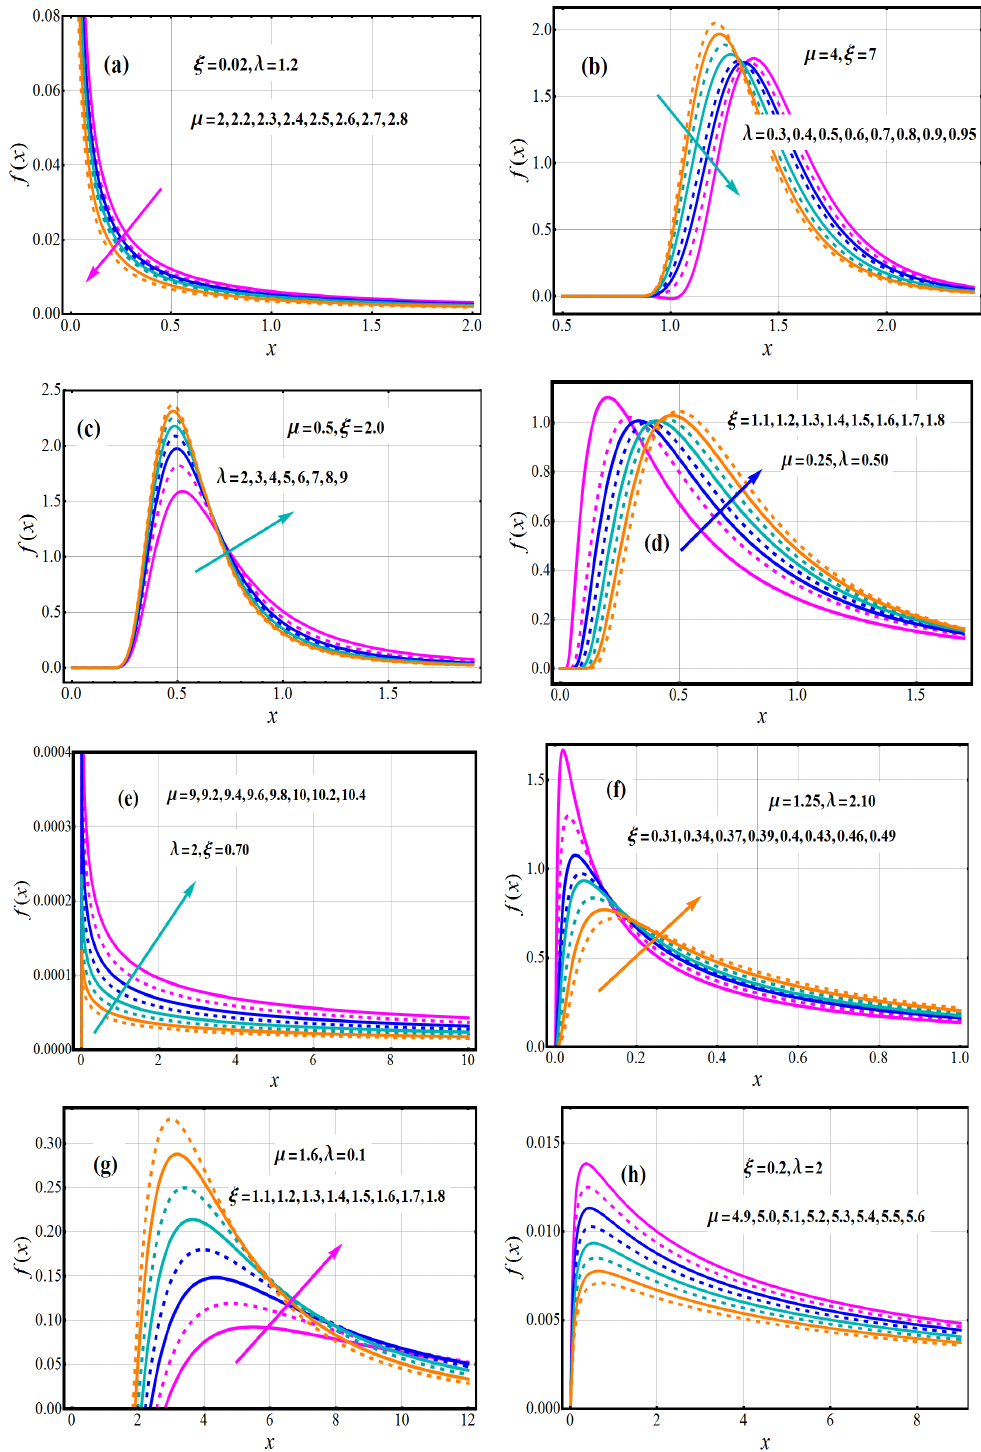
Fig. 1. The performance of PDF pro(cid:133)le of NIGT-II model against the (cid:22); (cid:24) and (cid:21) . Figure 1. The performance of the PDF profile of NIGT-II model against the µ , ξ and λ ( a – h